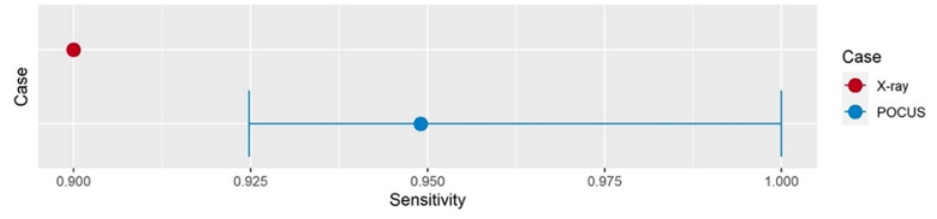
Figure 1. One-sided confidence interval of POCUS vs. X-ray imaging.